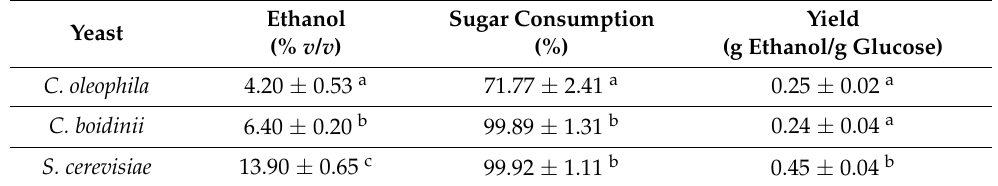
Table 1. Fermentations results using a synthetic glucose–fructose medium.